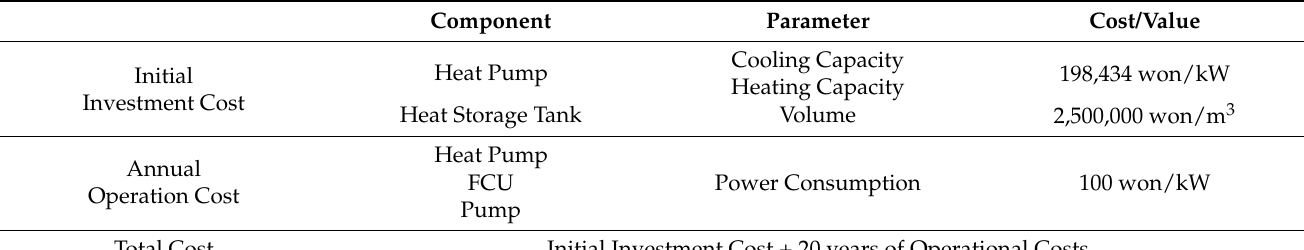
Table 5. Specifications of economic